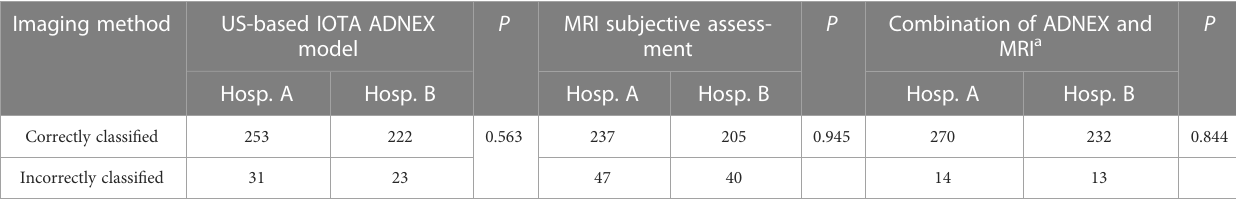
Table 4). The accuracy of the ADNEX model (0.90; 95% CI: 0.87 – 0.92)